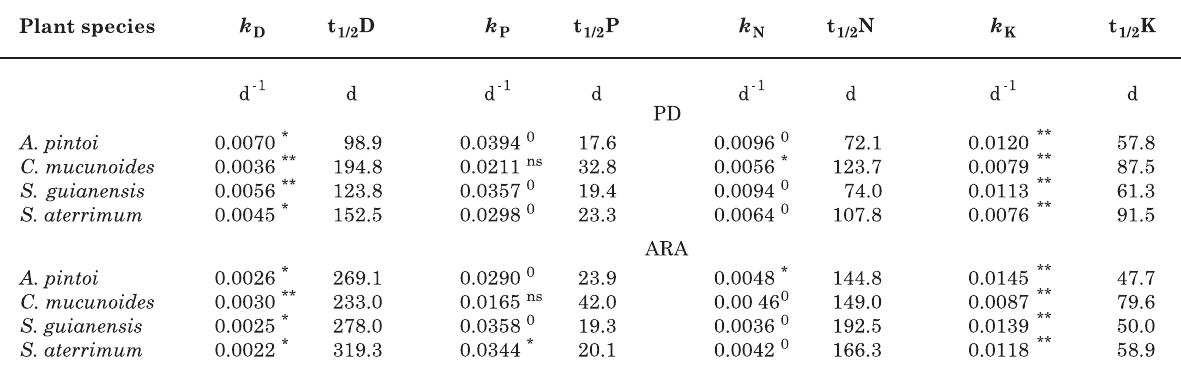
Table 2. Decomposition ( k equation